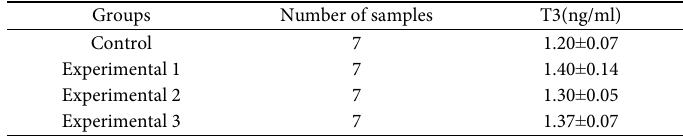
Fig. 7: TEM image of silver-cobalt nanoparticles produced (a) of silver nanoparticles synthesized during 75 seconds, (b) of silver nanoparticles synthesized in a period of 300 seconds (The electrical current adjusted at 1amp and rotational speed was 3000 rpm). Table 1. Comparison of different amounts of silver-cobalt nanoparticles on mean serum concentration of T3 hormone in the tested groups.